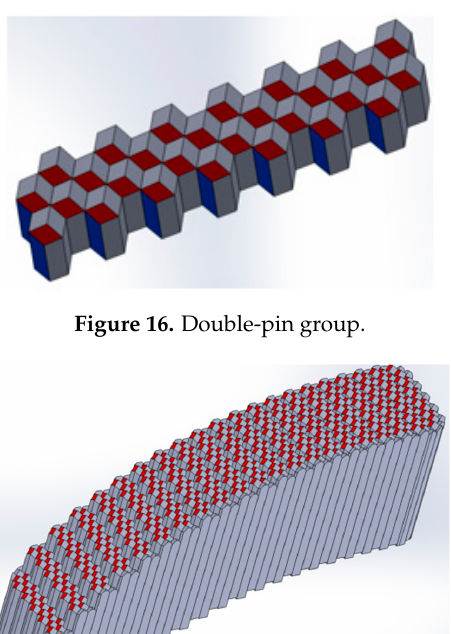
Figure 17. Primary CCCR constructed by double-pin groups.